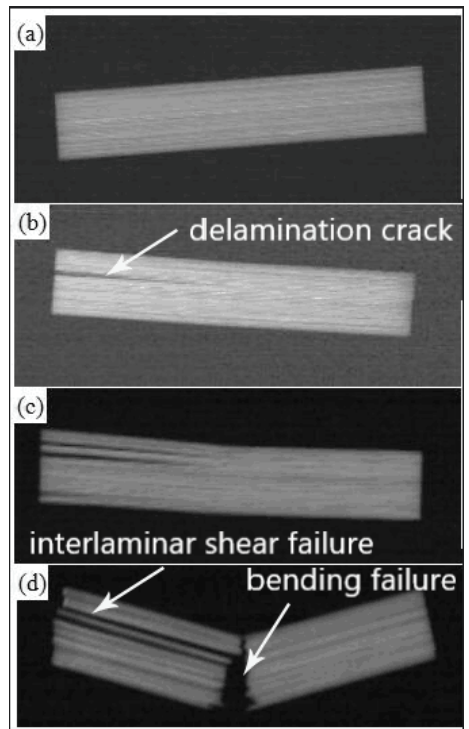
Figure 10. X-ray images of unpinned composite ( a ) before testing, ( b ) at maximum shear stress, ( c ) when load-bearing capacity dropped to 50%, ( d ) after